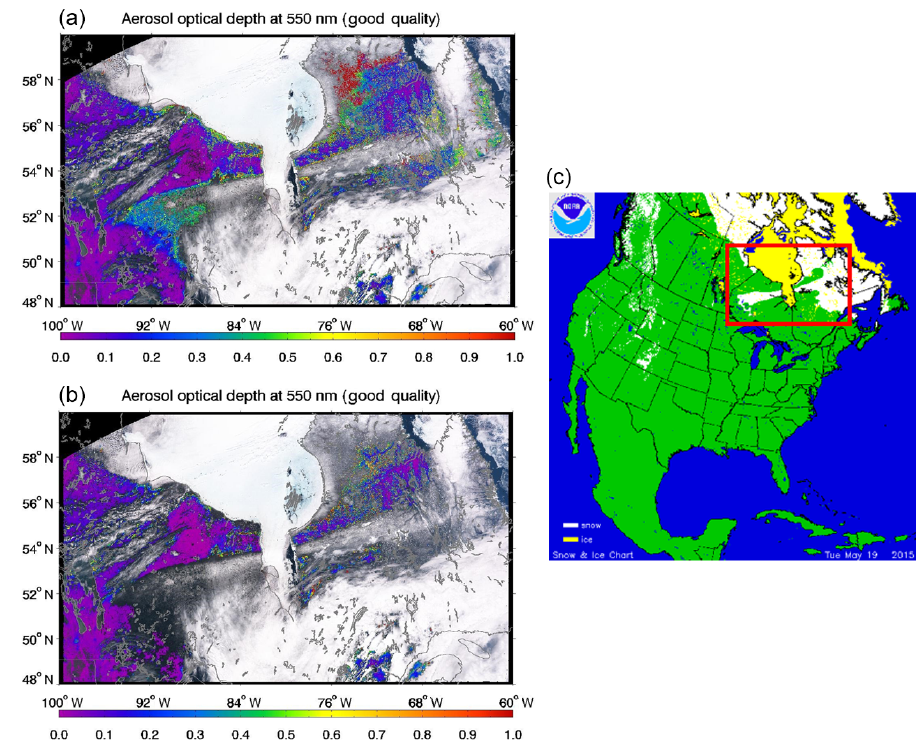
Figure 2. VIIRS “good”-quality AOD retrievals on 19 May 2015: (a) with the old VRA-based internal snow test; (b) with the new snow and snowmelt screening scheme; and (c) the snow cover map produced by the NOAA National Centers for Environmental Information (NCEI) (https://www.ncdc.noaa.gov/snow-and-ice/snow-cover/us/20150519, last access: 1 October 2018). The red square in (c) shows the areas covered in (a) and (b) . Note the snow cover to the east and south of the Hudson Bay in (c) and the associated anomalously high AOD values over the same areas in (a) but not in (b) .